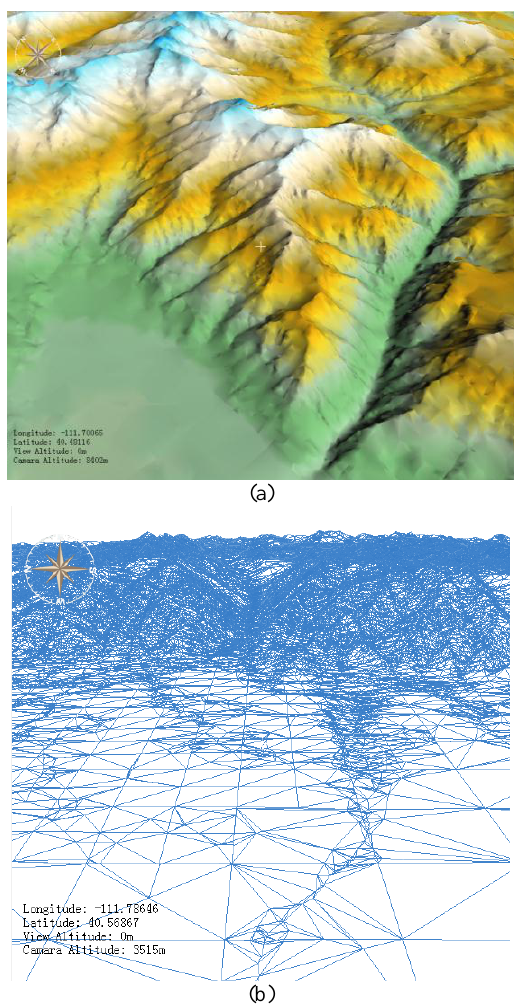
Figure 4. Visualize the morphologically preserved multi- resolution TIN surface in virtual globe. (a) The hill-shade effect. (b) The TIN wireframe.